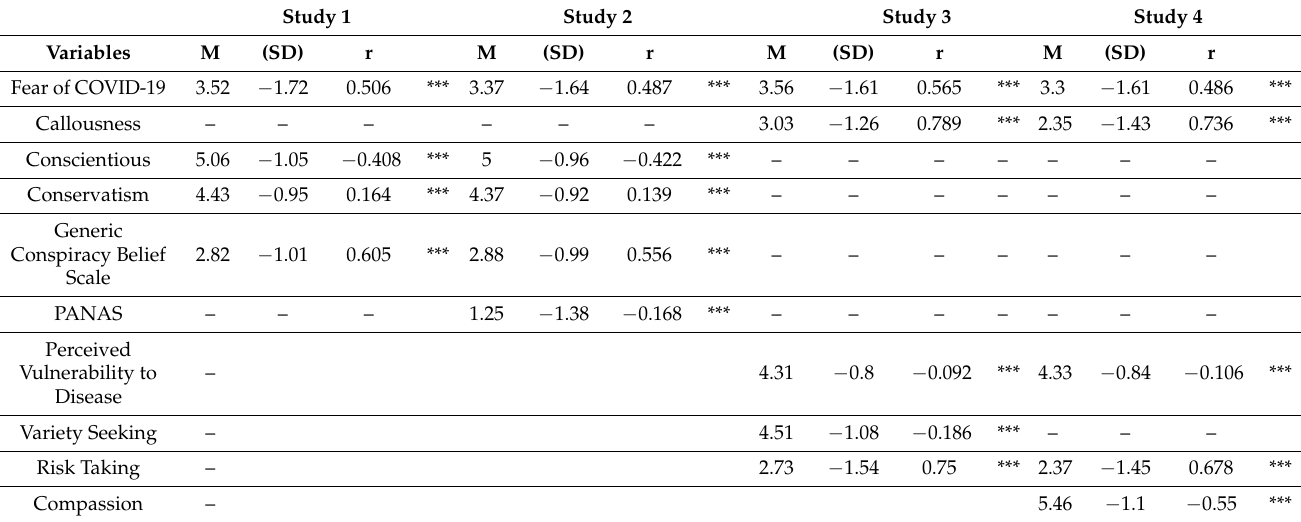
Table 5. Bivariate correlations of the 12-item COVID-19 Transmission Misinformation Scale (CTMS) with variables and de-